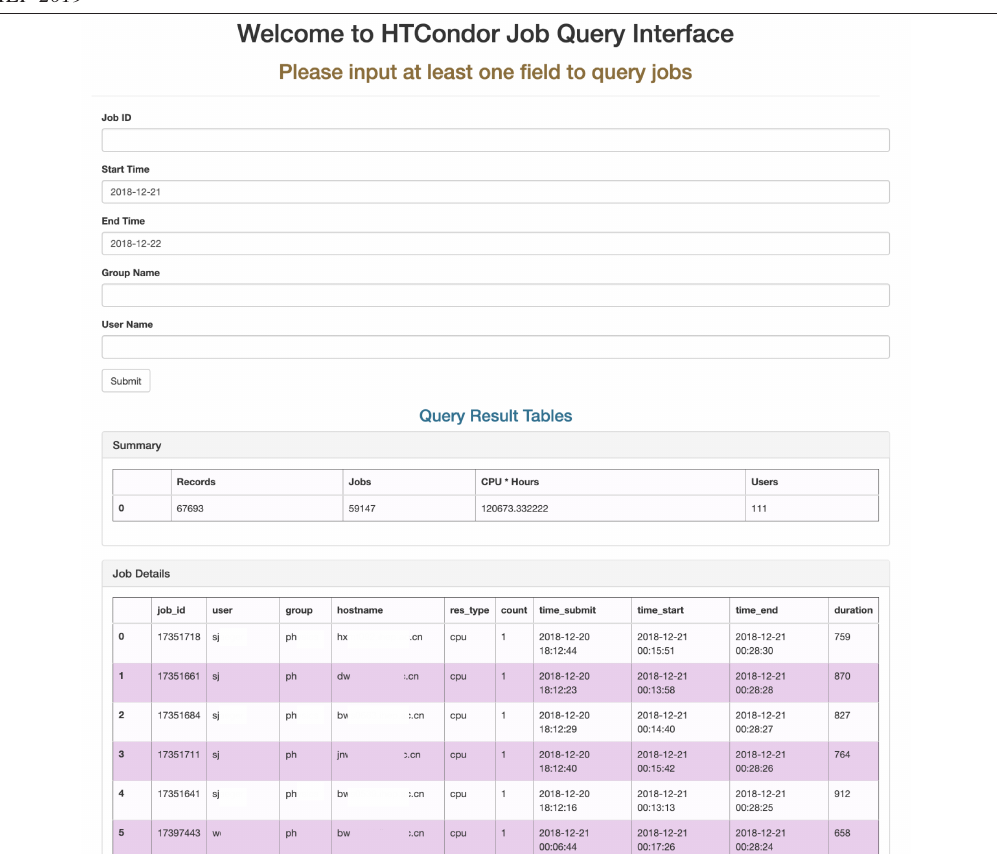
Figure 4: The job query table interface of